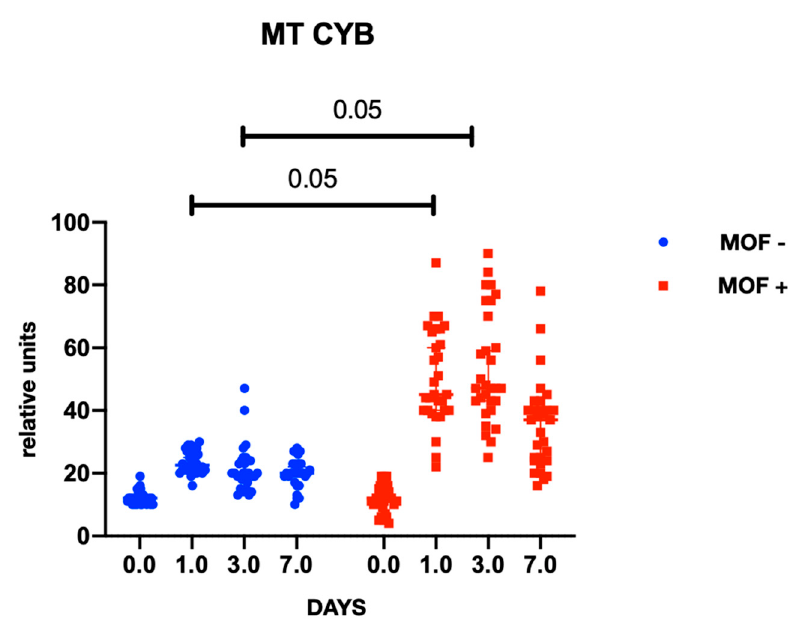
Figure 1. Cytochrome B gene expression.